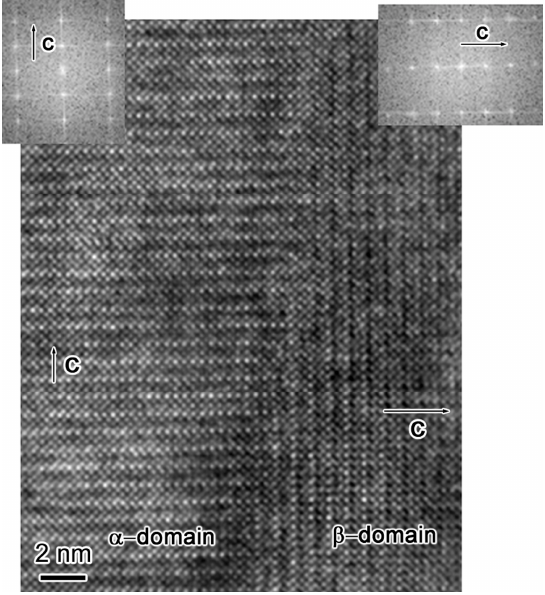
Figure 5. HRTEM image of sample-II shows the two-type domain structure. Left and right insets are the digital Fast Fourier Transformation images of their respective micrograph. The c -axis of different domains is indicated by the white arrows.